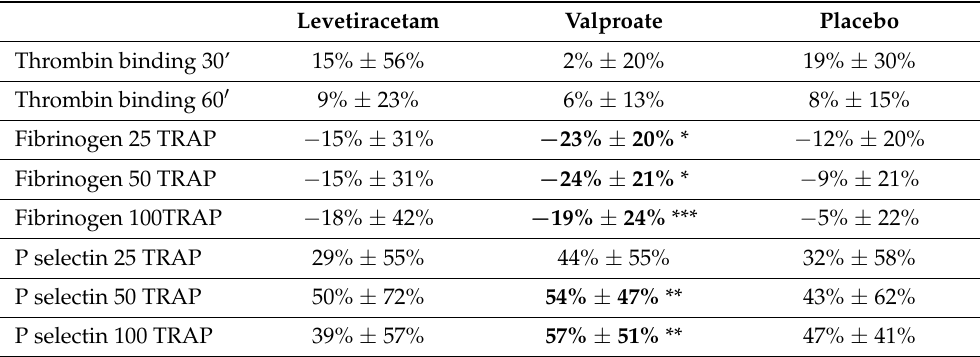
Table 2. Difference between thrombin binding, fibrinogen-FITC, and P-selectin (CD62P) expression before and 90 min after intake of study drugs presented as percentage (baseline as 100%), arithmetic mean, and standard deviation. Statistical comparisons between baseline and measures 90 min after intake were performed with Wilcoxon test.